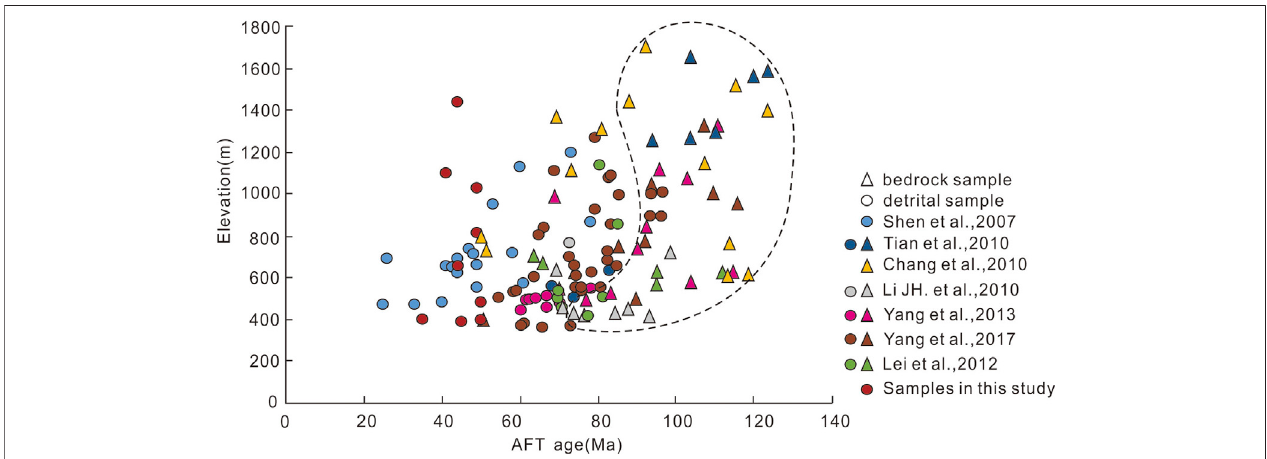
FIGURE 4 | Correlation between AFT ages and